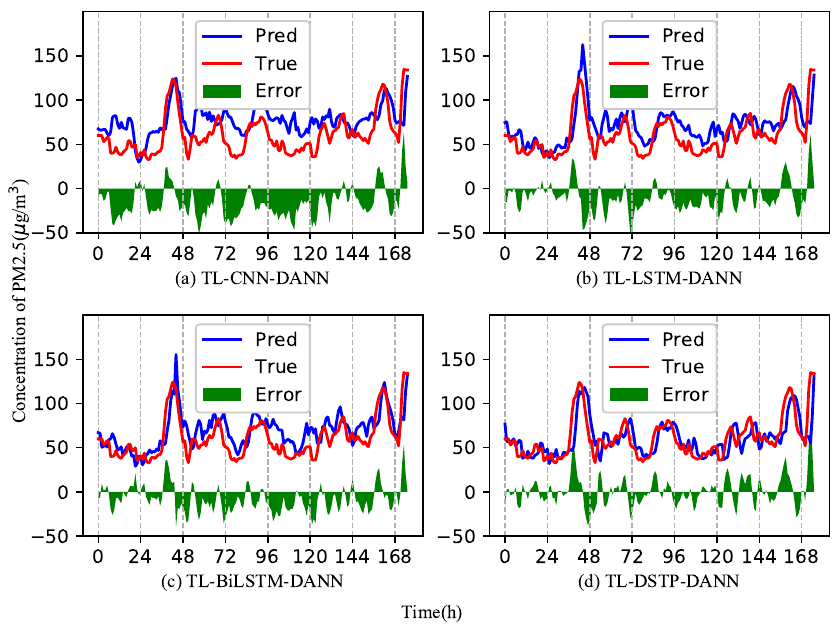
Figure 5. Prediction of PM2.5 concentrations at Tianjin site using models with different feature extractors.